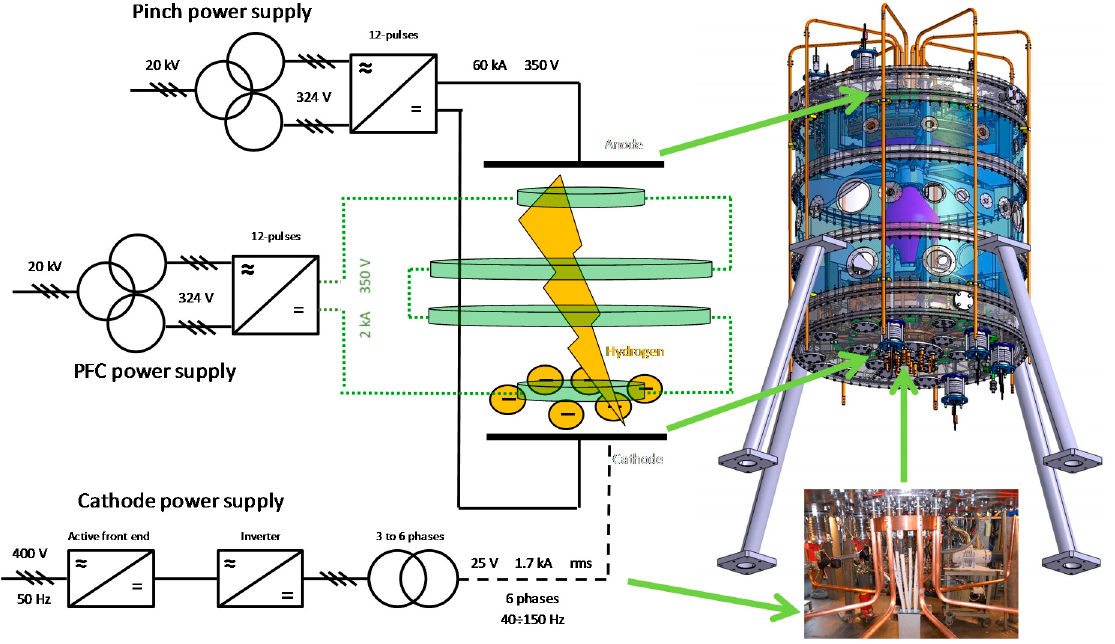
Figure 8. Summary of the PROTO ‐ SPHERA vessel, electros and power supplies.